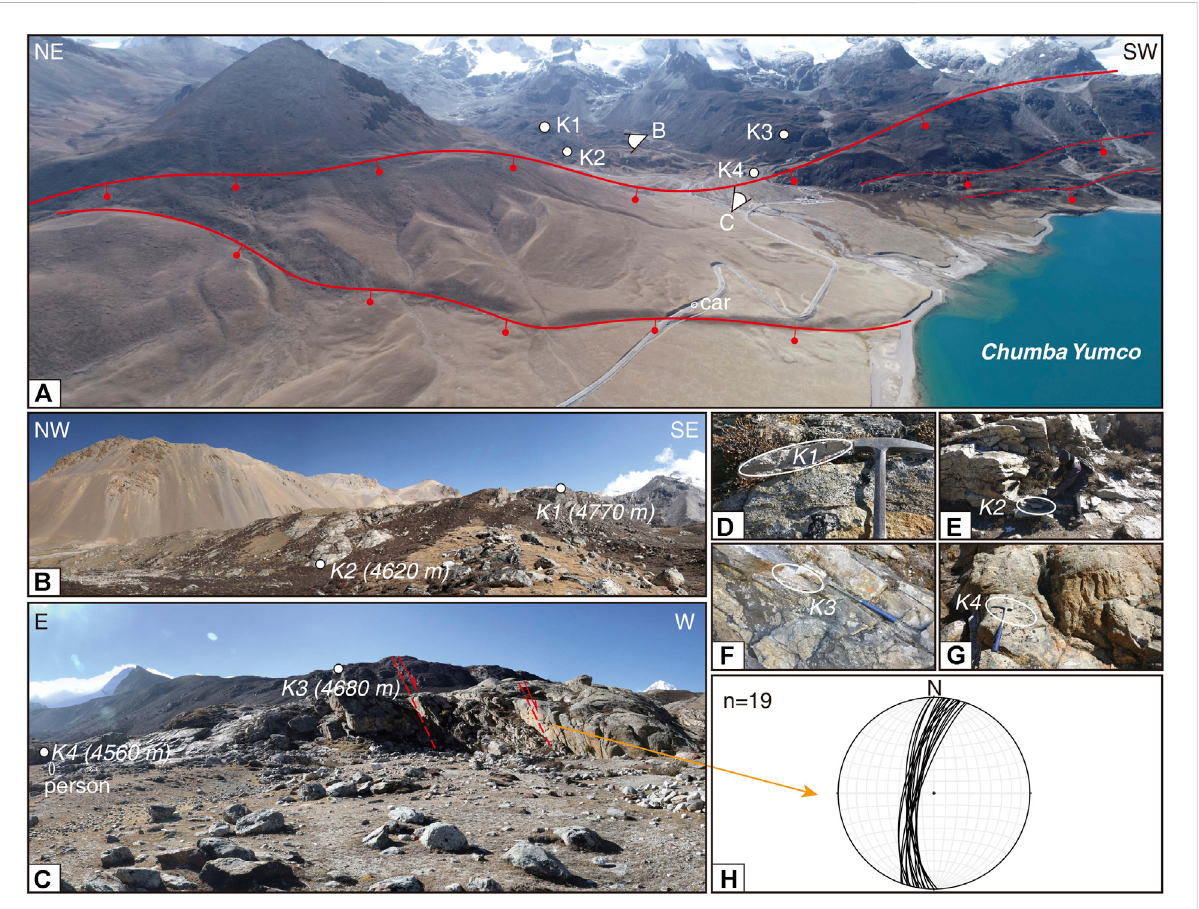
FIGURE 4 Field photos of active Yadong normal faults south of Chumba Yumco lake. (A) UAV photo of active faults south of the lake and location of samples K1 – K4. (B,C) Location of samples K1 (4,770 m), K2 (4,620 m) K3 (4,680 m), and K4 (4,560 m). (D – G) Outcrops of samples K1 – K4. (H) Foliations in the YGR normal fault south of Chumba Yumco lake, indicating the high-angle of active normal